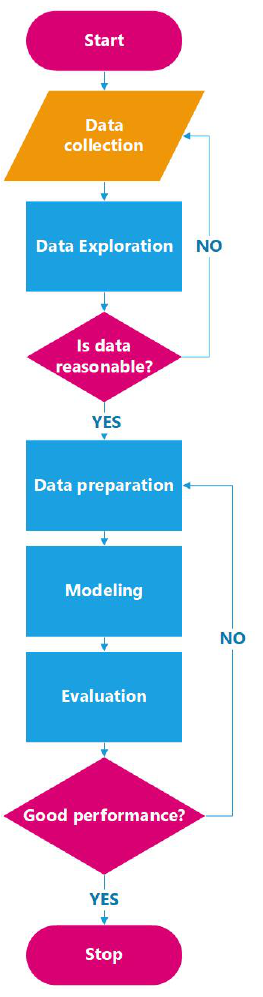
Figure 3. Flow diagram of the